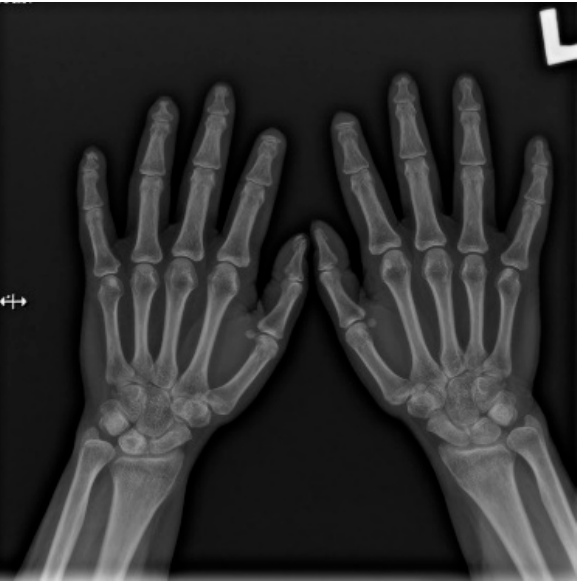
Figure 1. A ‐ P view of the hand radiograph in a patient with systemic sclerosis shows acro ‐ osteolysis especially expressed in the distal phalanx of the second finger of the left hand and in the distal phalanx of the second finger of the right hand.